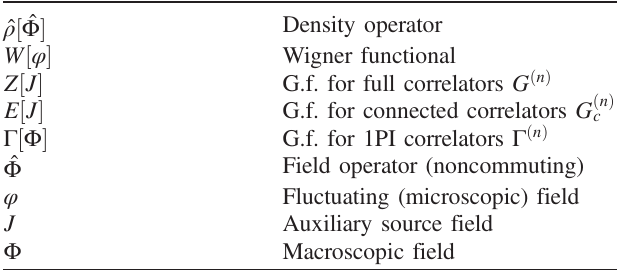
TABLE I. Overview over the different objects that appear in the general discussion. “ G.f. ” abbreviates “ generating functional ”